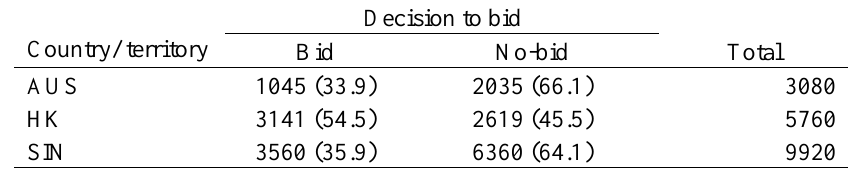
Table 2: Bid / no bid responses according to country /